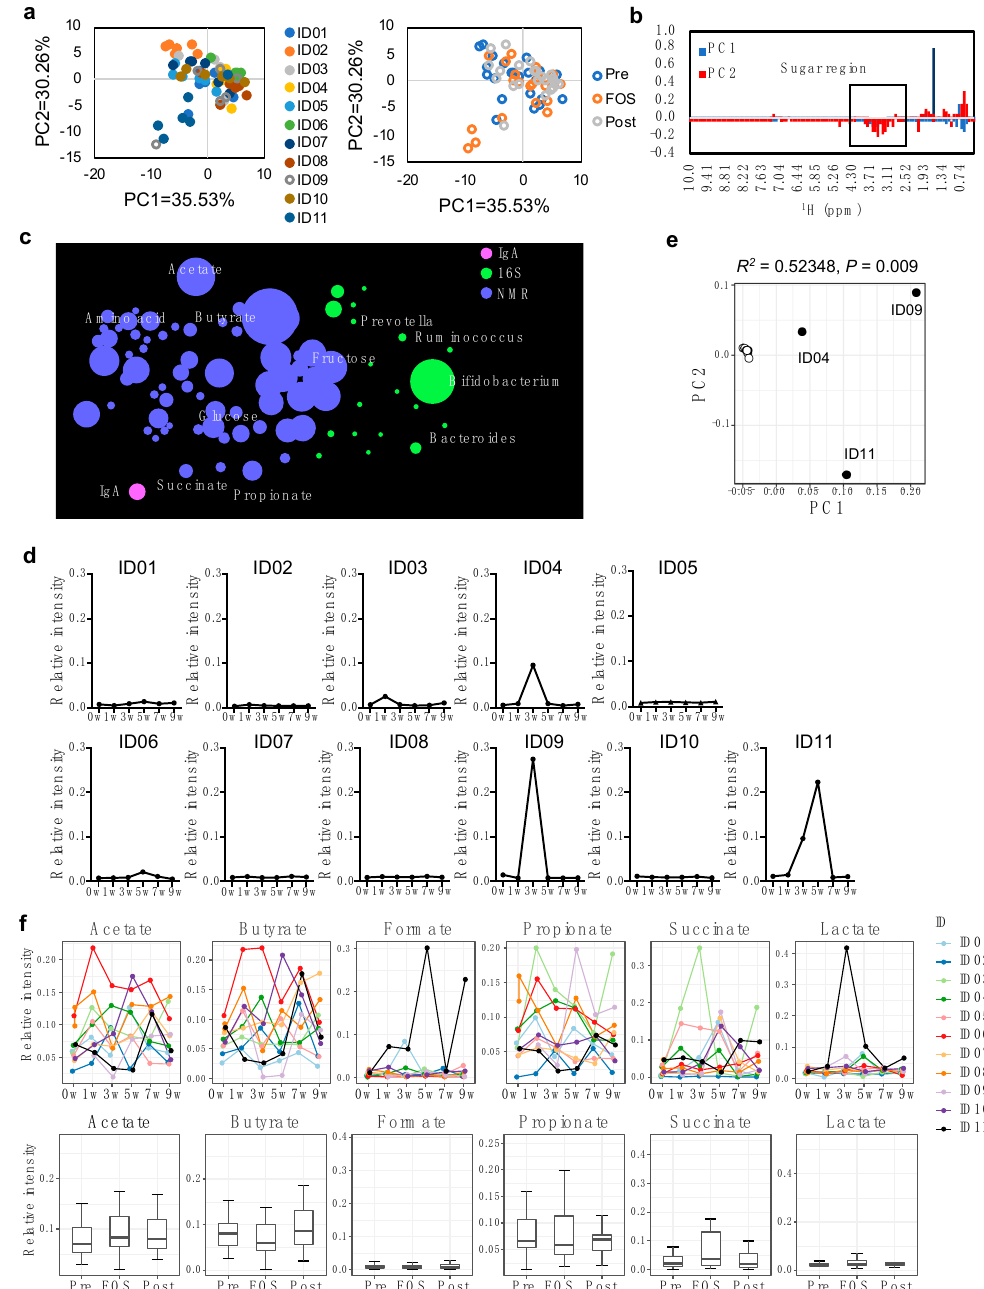
Figure 2. Differences of fecal metabolites upon intake of FOS. ( a ) Score plots of PCA for metabolic profiles of feces colored by individuals ( Left ) and sampling periods ( Right ). ( b ) Loading plot of PCA for fecal metabolome. Blue bars indicate PC1 direction and red bars indicate PC2 direction in the PCA plot in a. PC2 negative direction was influenced by the sugar region (rectangle). ( c ) The correlation network of feces was constructed as described in the Materials and Methods. The line between each element was connected to the calculated correlation coefficient and elements with p < 0.05. The size of each element reflects the relative value within each measurement. The amount of fecal IgA was shown in magenta, bacteria in green, and metabolites in blue. ( d ) Relative intensity of fructose in individual fecal samples. ( e ) PCoA based on Euclidean distance of the changes in fructose concentration over time in feces from individuals shown in ( b ). ADONIS revealed that ID04, ID09 and ID11 were significantly different from the others (R2 = 0.52348, p = 0.009). ( f ) Relative intensity of fecal SCFAs measured by